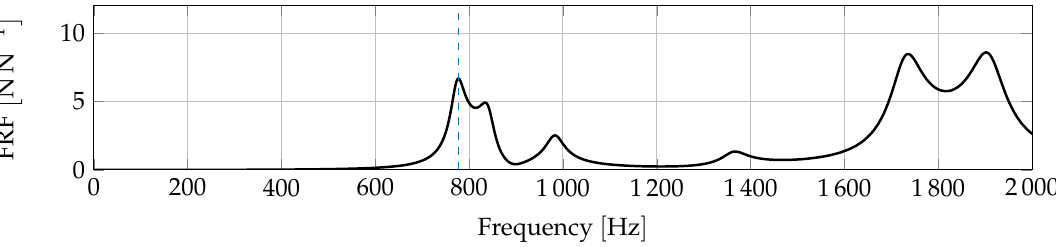
Figure 8. FRF between hard point track rod in x 2 -direction and wheel hub in x 3 -direction. 777Hz in